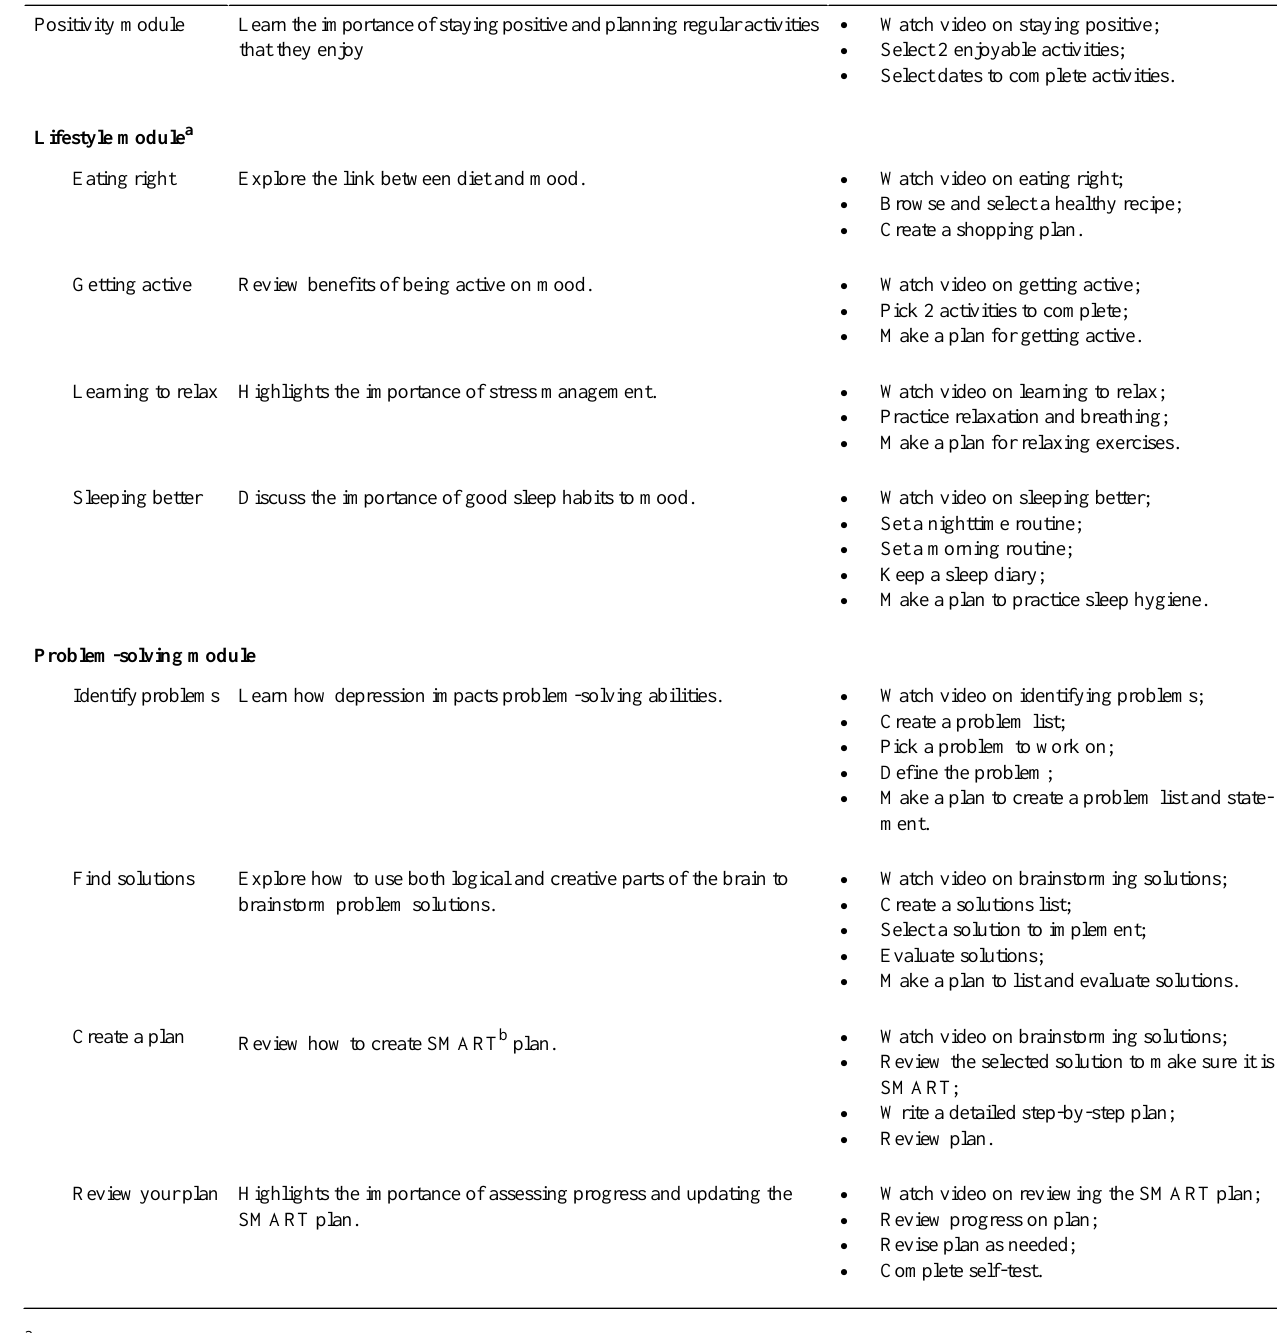
Tasks to be completed by participantsDescriptionLessons